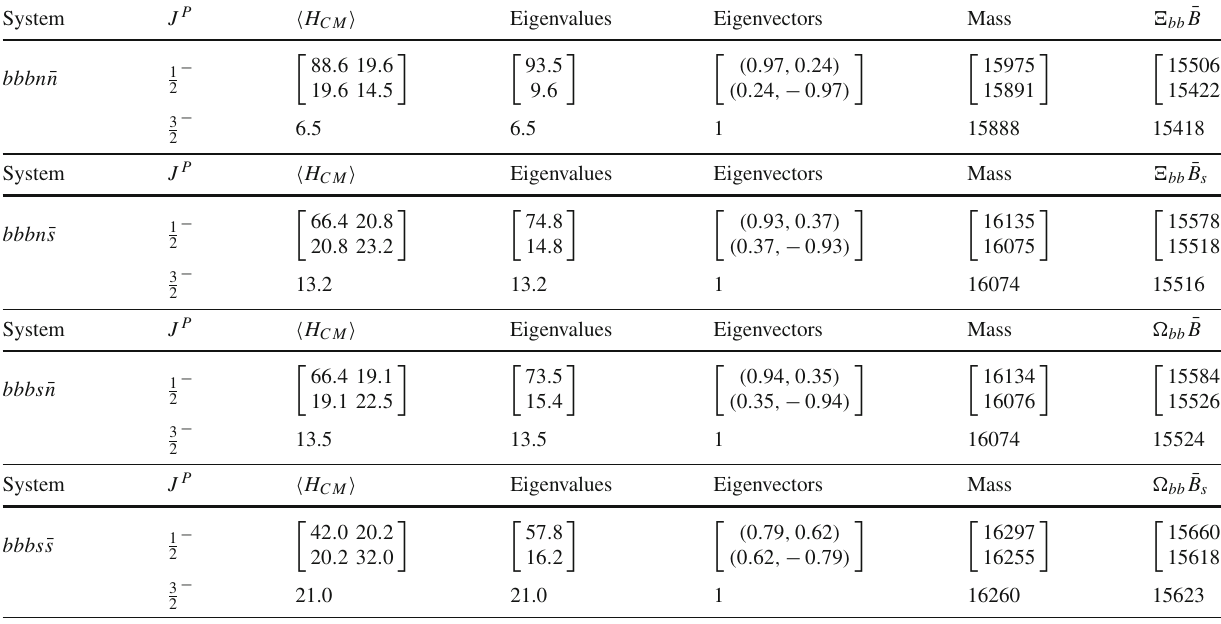
Table 6 Numerical results for the bbbq ¯ q systems in units of MeV. The masses in the sixth column are estimated with Eq. (18) and those in the last column with the ( bbq ) - ( b ¯ q ) type threshold